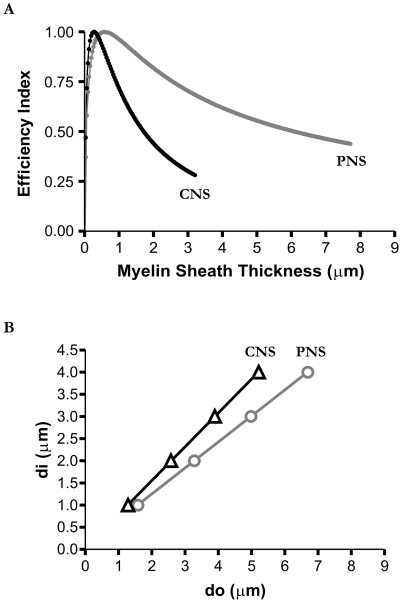
Optimized g-ratio for different neural systems.A: Efficiency index curves for a 1 µm diameter axon where δ = β = 1 (CNS-black curve) and where volume is less of a constraint δ = 0.6β (PNS-grey curve). Note that the peak is shifted to the right indicating that when volume is less of a constraint then the optimal sheath thickness is larger. B: Plots of di versus do representing different neural systems. In grey (circles) is when volume is less of a constraint (δ = 0.6β). In black (triangles) is when volume is as equally important as the other parameters (δ = β = 1) in defining an optimal structure (re-plotted from previous figure for comparison). The slopes of the lines, which represent the g-ratio, correspond to approximately 0.58–0.59 for the grey (PNS; correlation coefficient r = 1.0, R2 = 0.99; p<0.0001) and 0.76–0.77 for the black (CNS). Curves were generated using the parameters defined in Figure 1 and were the same for both the “CNS” and “PNS” plots with the exception of δ.